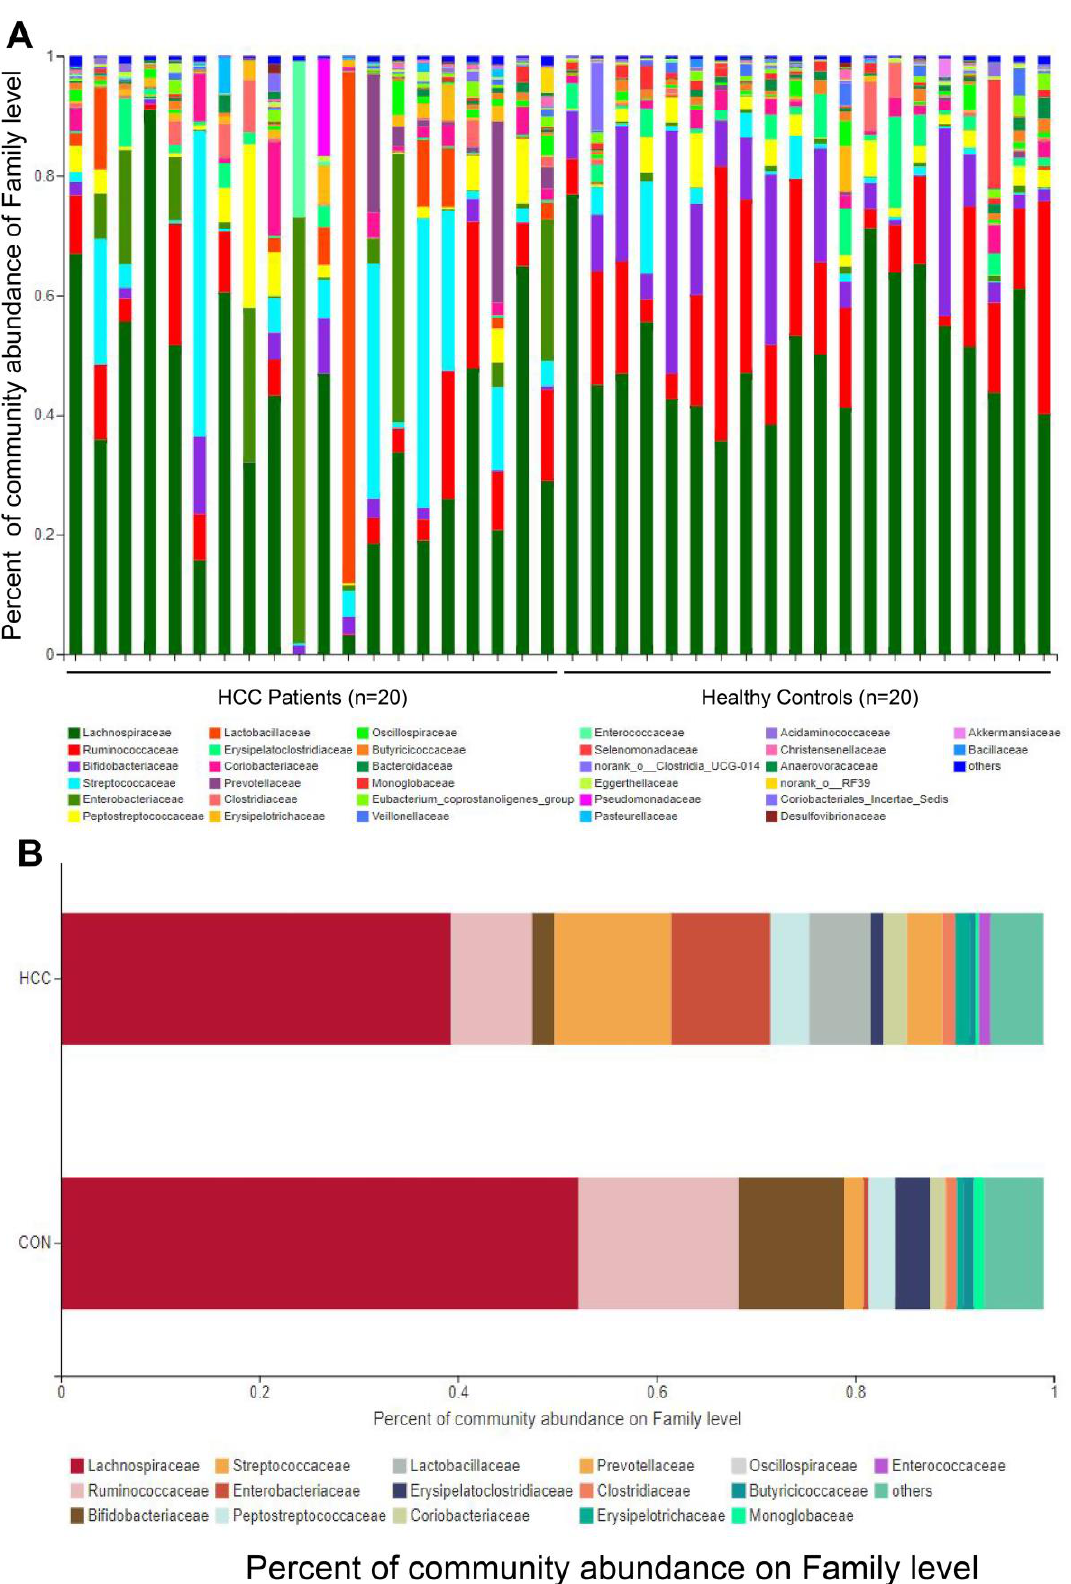
Figure 1. ( A ) Relative abundance of gut microbiota at family level of each sample, with different colored columns representing different species and the length of the column representing the relative abundance of the species. ( B ) Relative gut microbiota abundance at family level in HCC and CON groups.